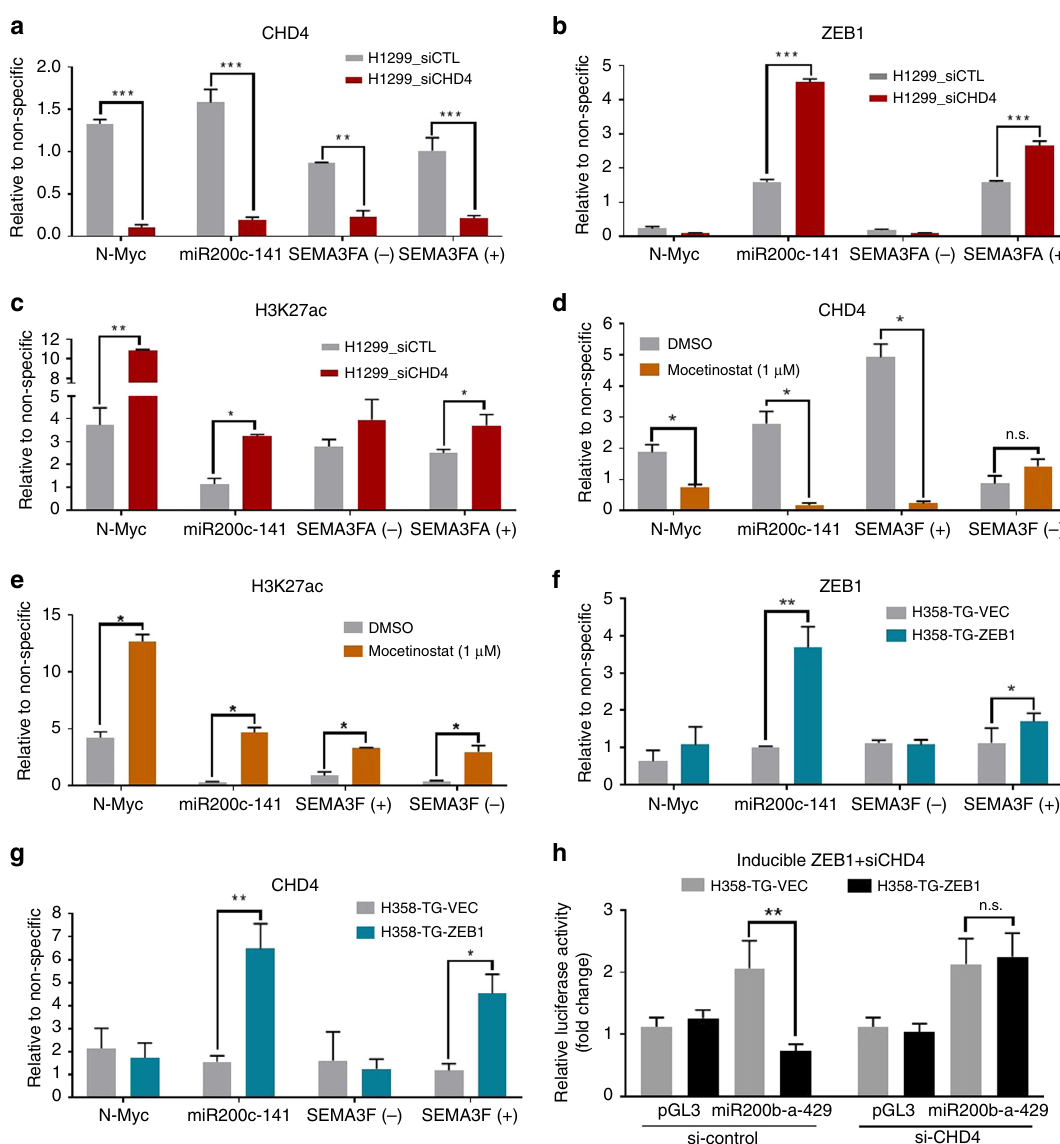
Fig. 3 The CHD4/NuRD complex is a ZEB1 co-repressor. Chromatin immunoprecipitation (ChIP) for ZEB1, CHD4, H3K27ac, and control IgG was performed for known ZEB1 target genes (SEMA3F and miR-200c) and established CHD4/NuRD complex target (N-Myc) in the NSCLC cell line H1299. Primers corresponding to SEMA3F intron 13 (SEMA3F-neg) were included as a negative control for ZEB1 binding. When indicated, ChIP experiments were normalized to the non-speci fi c IgG control. Graphs represent three experimental replicates; all asterisks indicate statistical signi fi cance by t -test ( n ≥ 3, * p ≤ 0.05); error bars represent standard error mean. Transient knockdown of CHD4 by siRNA signi fi cantly reduced CHD4 binding at each of the queried promoters ( a ) but promoted ZEB1 binding ( b ). Despite increase ZEB1 binding, acetylation of H3K27 ( c ) increased at the miR-200c and SEMA3F promoter. d Relative CHD4 binding in the cell line H1299 after 24 h of treatment with the class I HDAC inhibitor, mocetinostat (1 μ M). e Reduced CHD4 binding is observed upon treatment, corresponding with increased H3K27ac. f , g In the human NSCLC cell line H358, ZEB1 or GFP vector were overexpressed for 24 h prior to ChIP. ZEB1 and CHD4 concurrently bind to the promotor of miR-200 and SEMA3F, but not N-Myc. In addition, CHD4 binding to the promoter of miR-200c and SEMA3F occurs only upon ZEB1 overexpression. h Relative normalized luciferase activities from reporter constructs of either empty vector (pGL3), or a 321 base pair upstream fragment of the miR-200b-a-429 promoter 29 . Vectors were transfected in H358-GFP control or ZEB1-expressing cells, which were pre-transfected with siRNA control or siRNA targeting CHD4. Doxycycline induction was conducted prior to quanti fi cation of luciferase activity. Graphs represent normalization to control; all asterisks indicate statistical signi fi cance by t -test ( n ≥ 3, * p ≤ 0.05); error bars represent